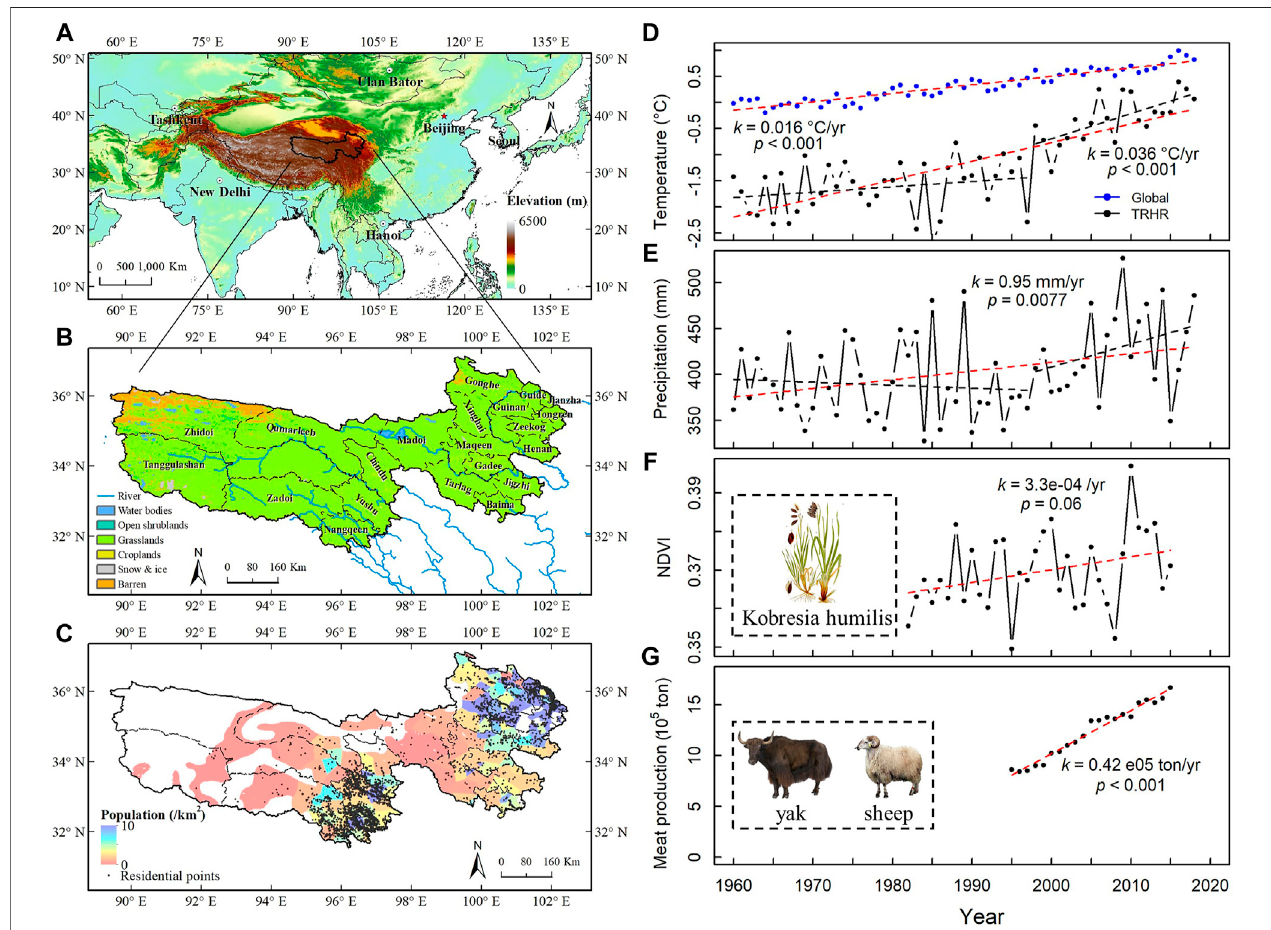
FIGURE 1 | The background and climate change of the Three-River Headwaters Region (TRHR). (A) Location of the TRHR; (B) Land cover of the TRHR; (C) Population density in 2015; (D) Station-based annual mean air temperature from 1961 to 2018; (E) Station-based annual mean precipitation from 1961 to 2018; (F) Growing season (May to September) NDVI from 1981 to 2015; (G) Grazing meat production from 1995 to 2015.